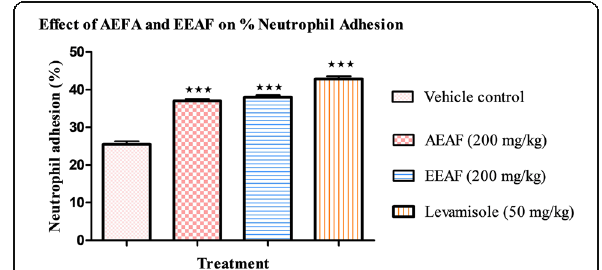
Fig. 11 Effect of AEAF and EEAF on Neutrophil adhesion test in mice. Results were expressed as mean ±SEM, ( n = 6). Statistical analysis was performed with one-way analysis of variance (ANOVA) followed by Dunnett ’ s multiple comparison test. # P < 0.05, ## P < 0.01 as compared with NC. P value less than < 0.05 was considered to be statistically significant. * P < 0.05, ** P < 0.01 and *** P < 0.001, when compared with control